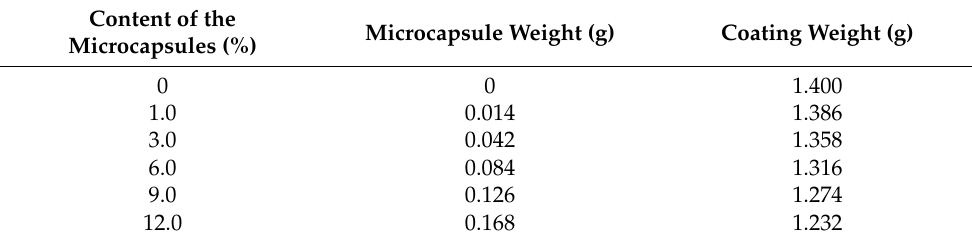
Table 6. Dosage list of the water-based paint films. Content of